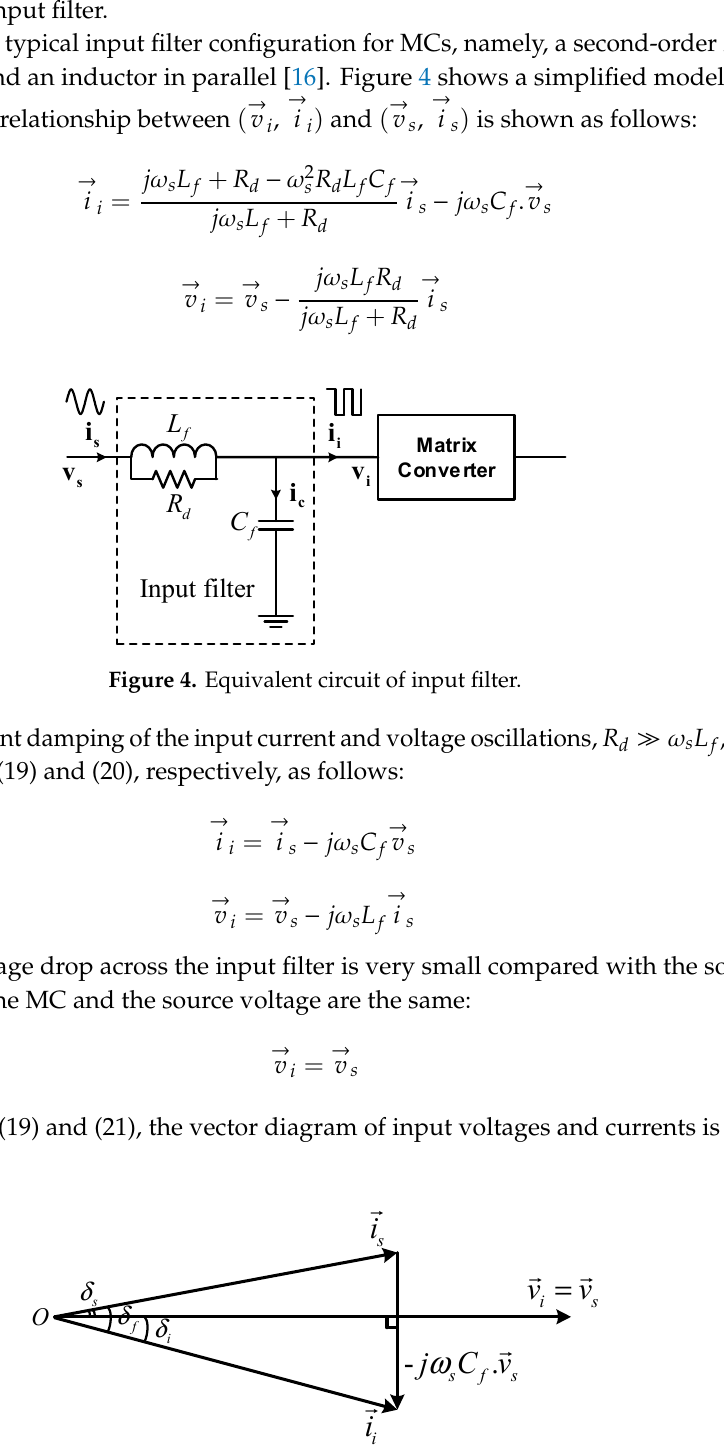
Figure 5. Vector diagram of input voltages and currents.